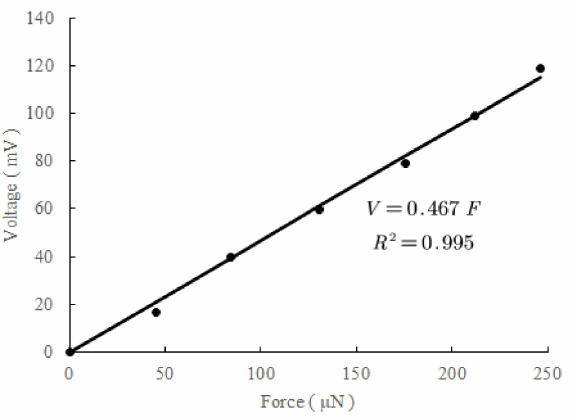
Figure 9. Measurement results of the integrated normal force sensor. Sensitivity was calculated to be 93.5 µ V/ µ N/V.